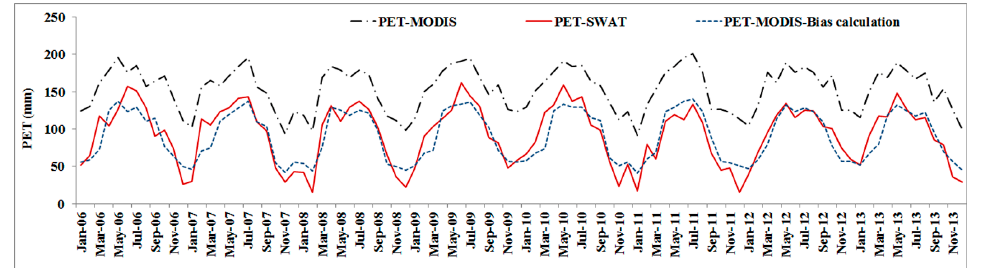
Figure 7. Comparing PET extracted from MODIS-MOD16 with one measured using the Penman-Monthieh method. For bias correction, MODIS data were multiplied by 0.45 for the period of October–March and 0.70 for April–September.